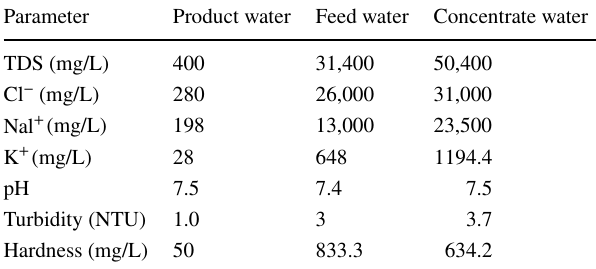
Table 1 Average of chemical parameters of CMU desalination plant Parameter